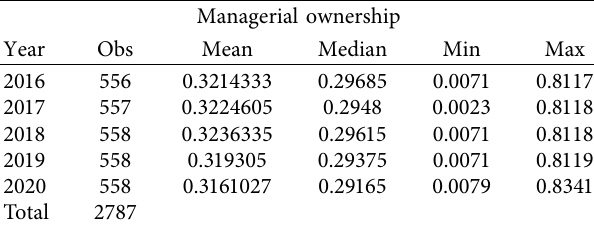
Table 2: Managerial ownership from 2016 to 2020. Managerial ownership